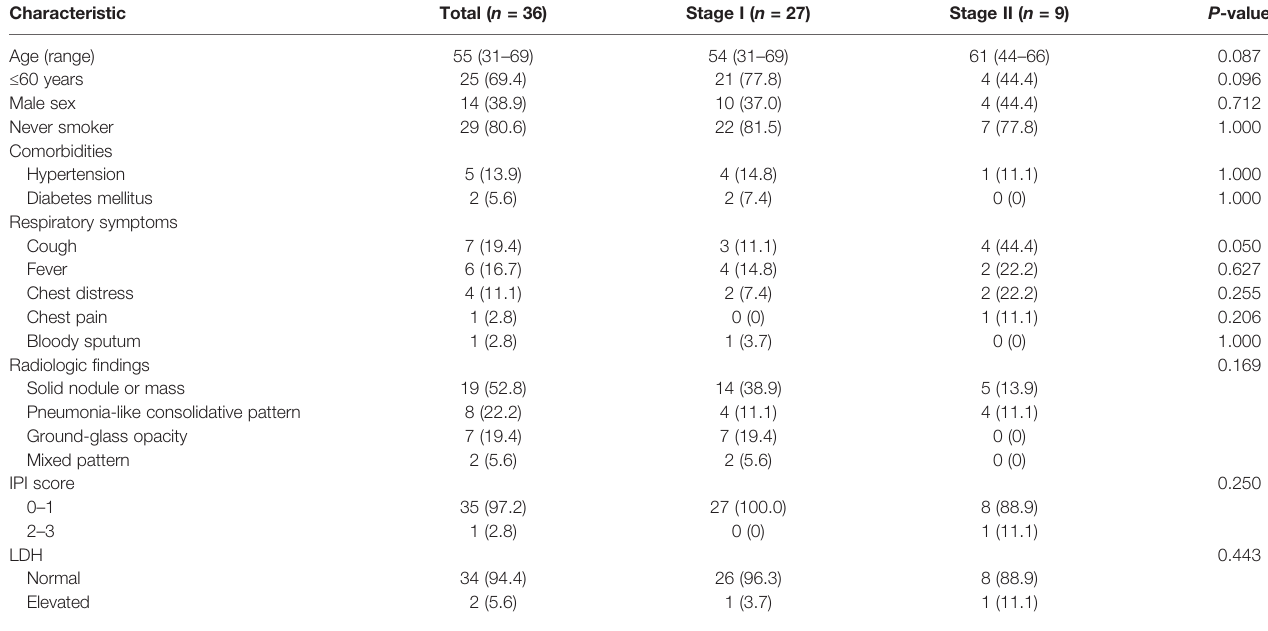
TABLE 1 | Clinical characteristics of the patients with primary pulmonary lymphoma. Characteristic Age